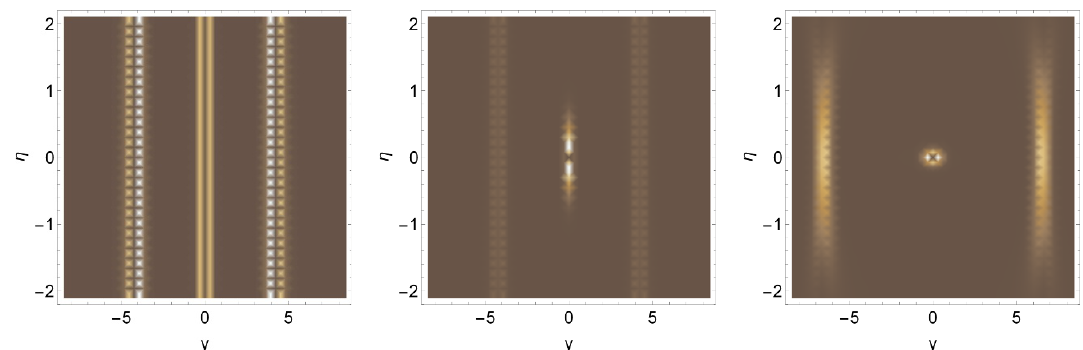
n x = x ? ; (cid:17) = 0 ; ! 1 = 0 : 5 ; ! 2 = 0 : 05 0